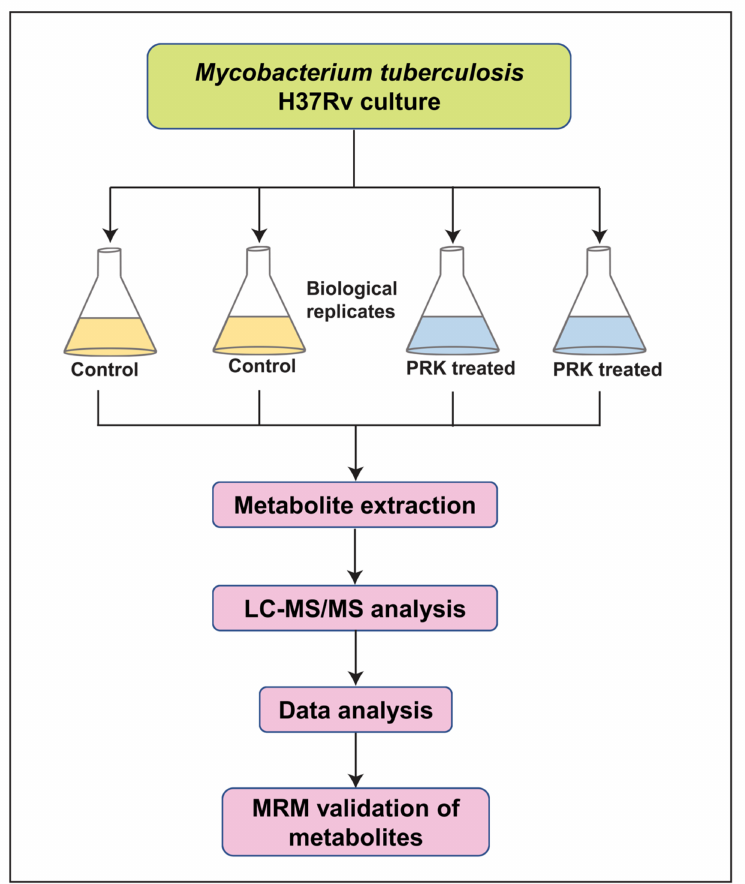
Figure 1. Schematic representation of the metabolomics experimental pipeline. The details of samples and the experimental pipeline employed for targeted and untargeted approach are